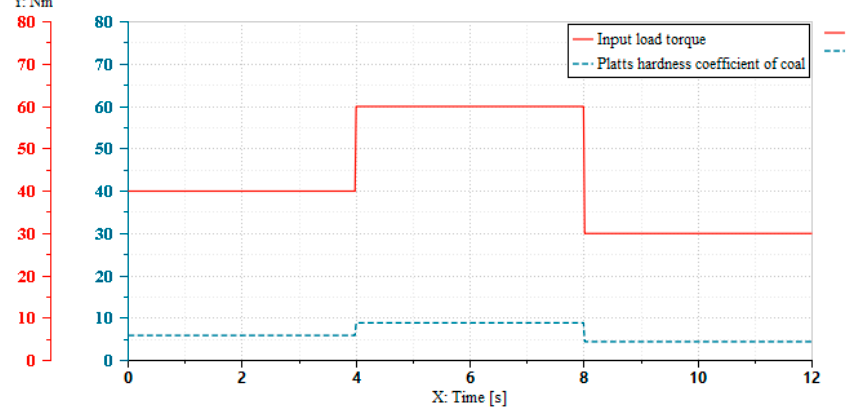
Figure 8. The input torque signal and corresponding coal hardness coefficient under the coal hardness of sudden change.